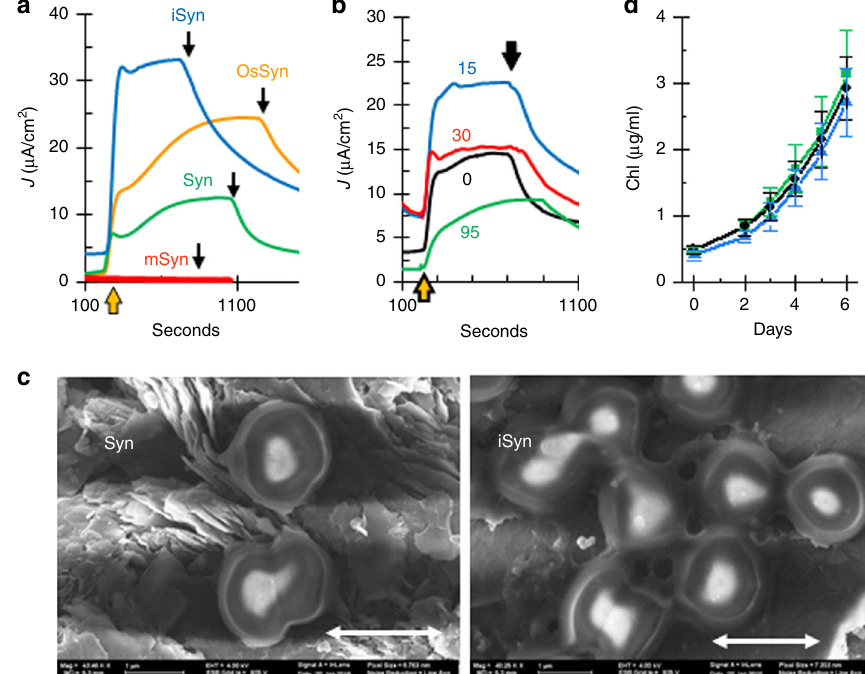
Fig. 3 iSyn are living, modi fi ed, and clustered cells. a CA measurements of Synechocystis cells (Syn, green), cells undergone a mild osmotic shock treatment, (OsSyn, Orange), cells undergone a gentle pressure treatment (iSyn, blue), and thylakoid membranes (mSyn, red). b CA measurements of cell undergone treatment with micro fl uidizer at 0, 15, 30, and 95 psi, as indicated in the fi gure. c SEM image of iSyn (right) and Syn (left) on graphite. Scale bars are 2 μ m. d Growth curve of Syn (green), iSyn (black) and iSyn that were illuminated for 30 min in the BEPC (blue) in liquid medium. The vertical lines show the standard deviation ( n =